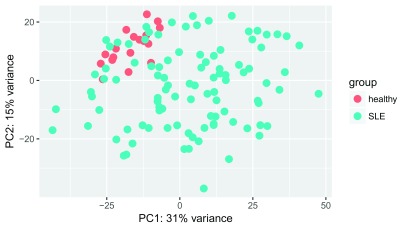
Scatter plot showing results of a PCA with samples coloured according to their disease status.